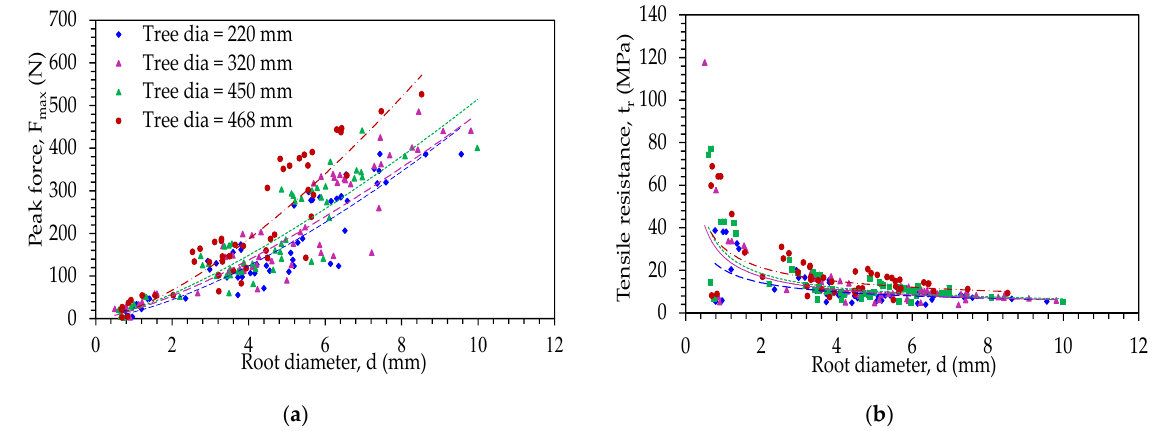
Figure 9. Roots tensile test results with power fit functions ( a ) F max and d ( b ) t r and d. Table 4. Statistical values of the roots tested and roots tensile strength.